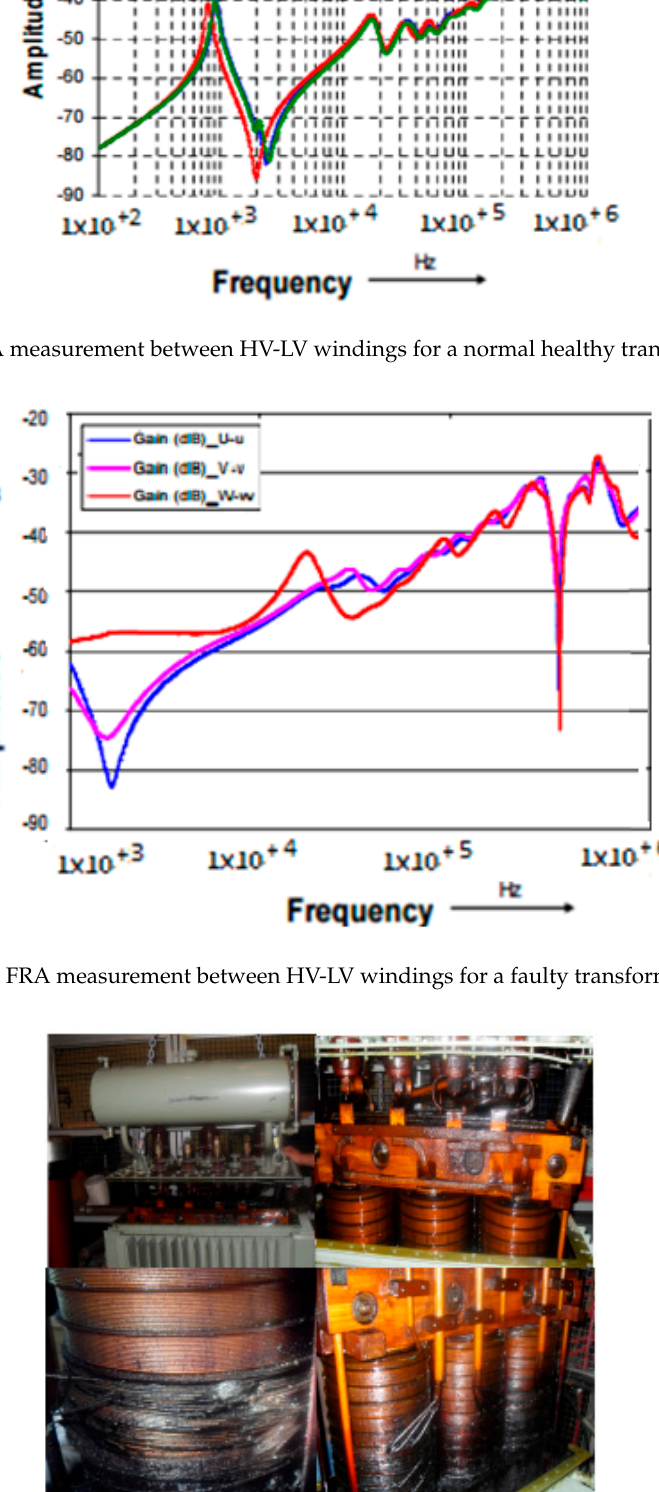
Figure 12. Visual inspection showing deformation of winding (W) [21].